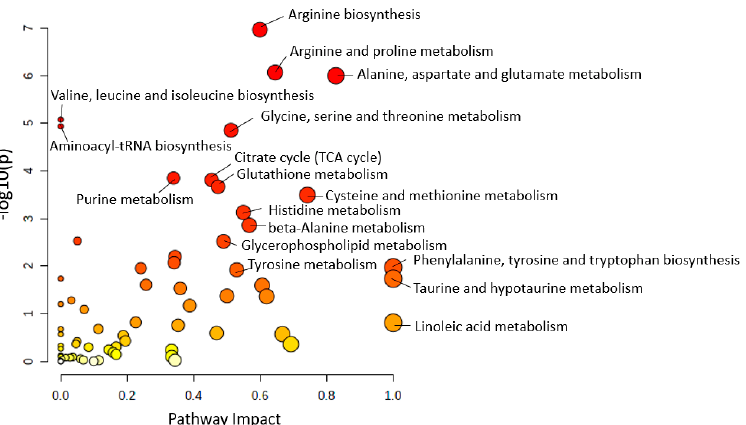
Figure 1. Metabolic pathway analysis in biological samples (CSF, brain, and plasma) of 43 human AD studies. The size of the circle corresponds to the pathway impact score and was correlated with the centrality of the involved metabolites. Darker circle colors indicated more significant changes in metabolites in the corresponding